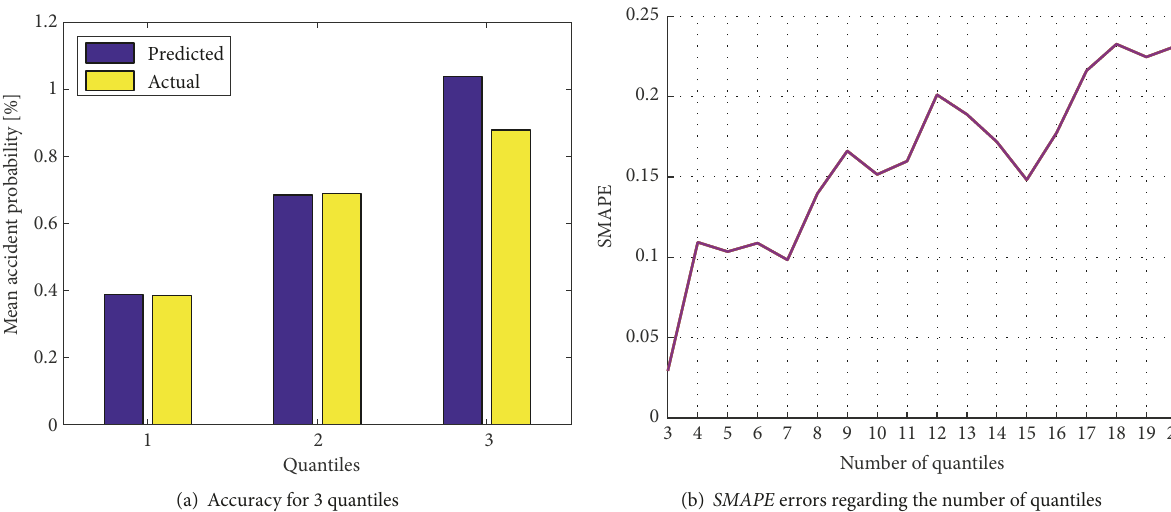
Figure 12: Accuracy and 𝑆𝑀𝐴𝑃𝐸 errors for the selected model.